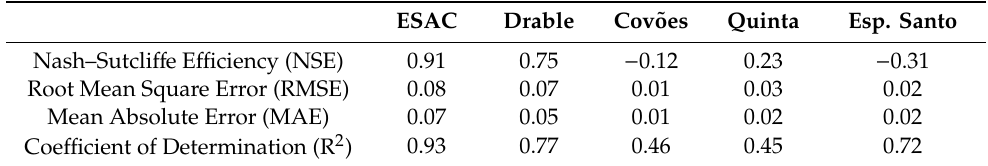
Table 2. Goodness-of-fit of the hydrologic HEC-HMS model in simulating hourly runo ff at the outlet of Ribeira dos Cov õ es catchment (ESAC) and in four upstream sub-catchments (Drable, Cov õ es,